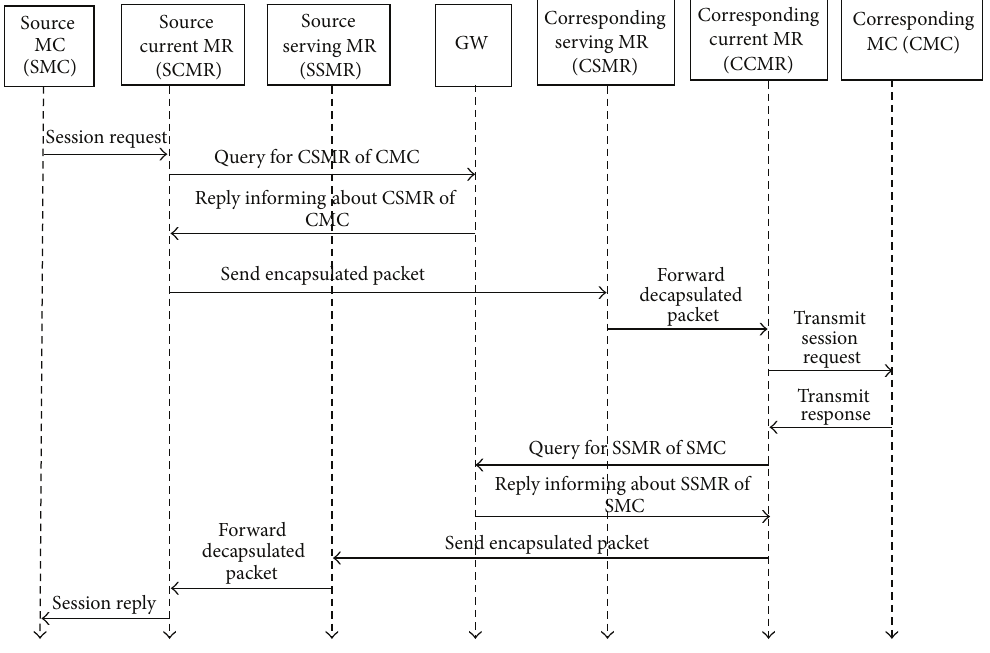
Figure 3: Communication between mesh nodes for session